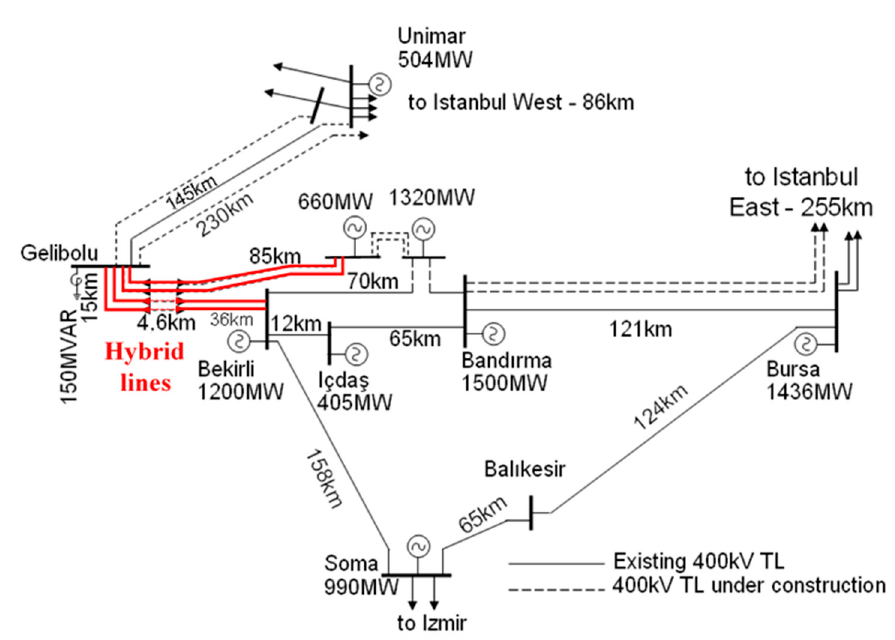
Figure 3. Single-line diagram of the Southern Marmara Sea 400 kV network (hybrid lines Gelibolu– Single-line diagram of the Southern Marmara Sea 400 kV network (hybrid lines Berkili are highlighted in red). Gelibolu–Berkili are highlighted in